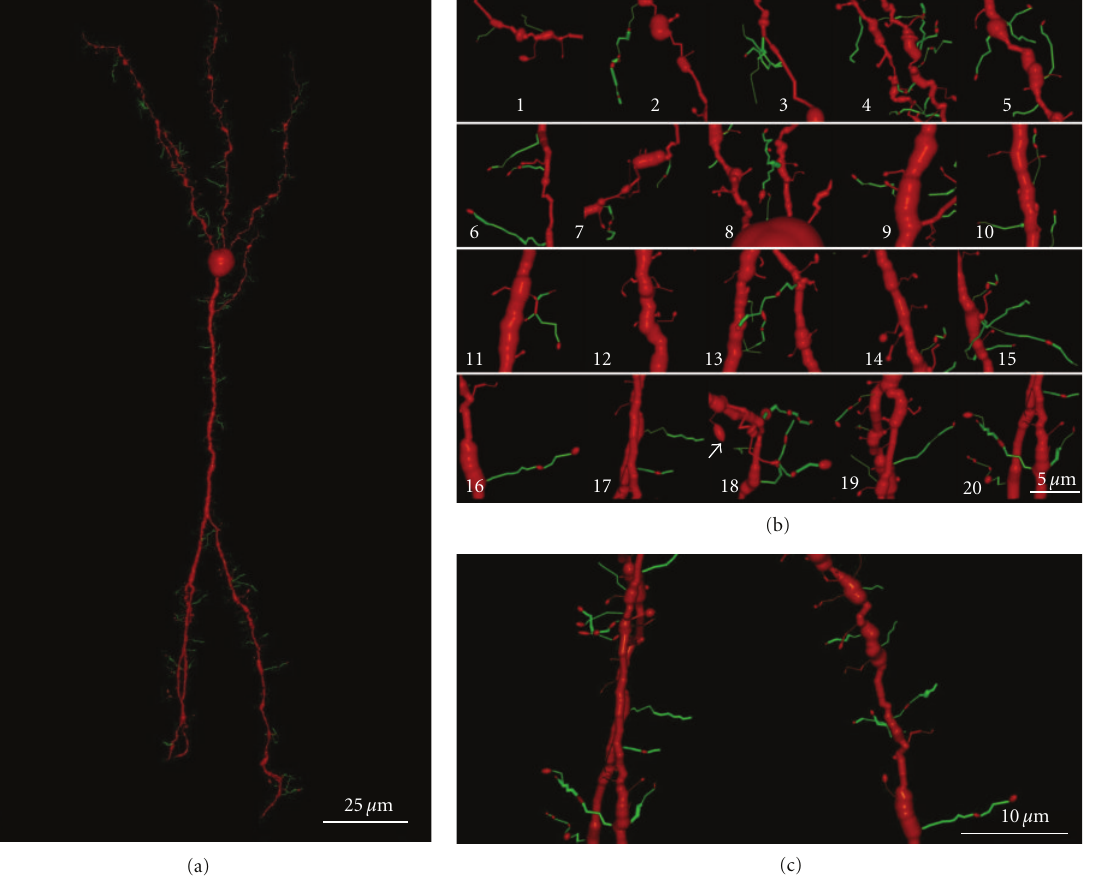
Figure 18: (a) Depicts three-dimensional reconstructions, granule cell, olfactory bulb, one-month-old dog, Cajal histological preparation, Golgi-method. (b) Filopodia, protospines and spines; 1–10: inner dendrites (above the soma);11–15: peripheral dendrites (below the soma); 16–20: peripheral apical tuft. (c) Filopodia, protospines and spines of the peripheral apical tuft. Filopodia and protospines are color coded in green. The arrow in (b) 18 points to a very big head with long neck possibly a gemmule , a characteristic appendage of this type of